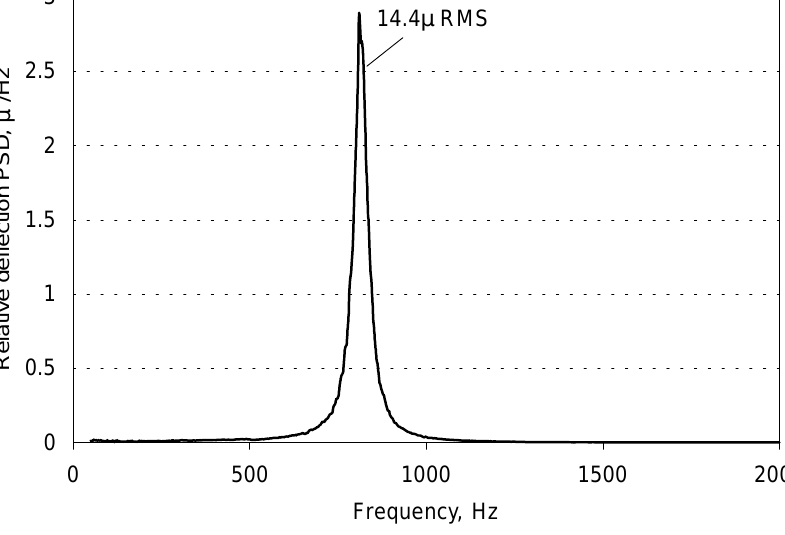
Fig. 8. Experimentally measured dynamic response of cold finger.